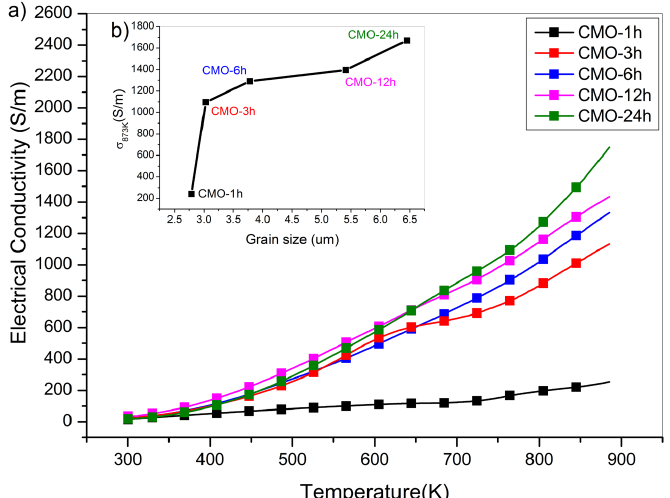
Figure 5. a) Temperature and b) grain size dependence of electrical conductivity for CMO